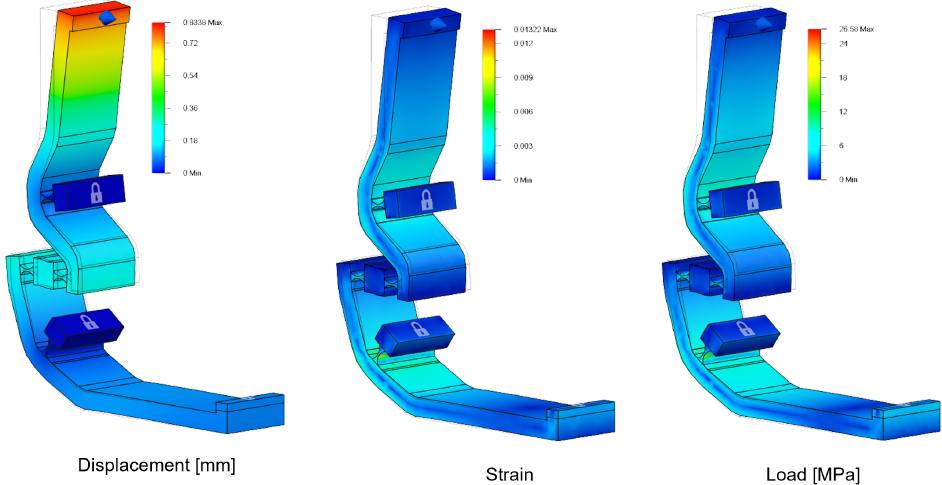
Figure 4. FEM analysis of the flexure hinge mechanism with 1 N input loading force, constrained moving plate, and 0.1 mm thickness of the hinges.